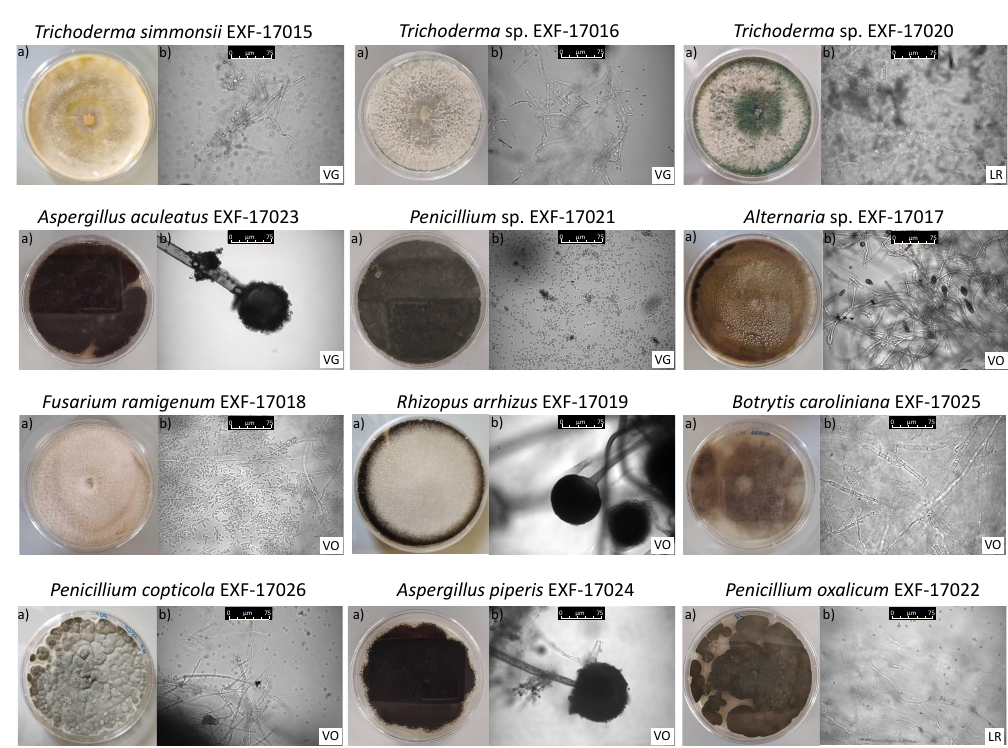
Figure 1. ( a ) Mycelial growth of fungal colonies on Petri dishes on a PDA medium of the twelve iso- lated plant-associated fungi from the three vineyards. ( b ) Microscopic observations of the mycelium and the reproductive spores of the isolated fungi. Scale bar 0–75 µ m (Magnification 400 × ). Abbrevia- tions: VG—Vigna Grande; VO—Vigne Olcru; LR—La